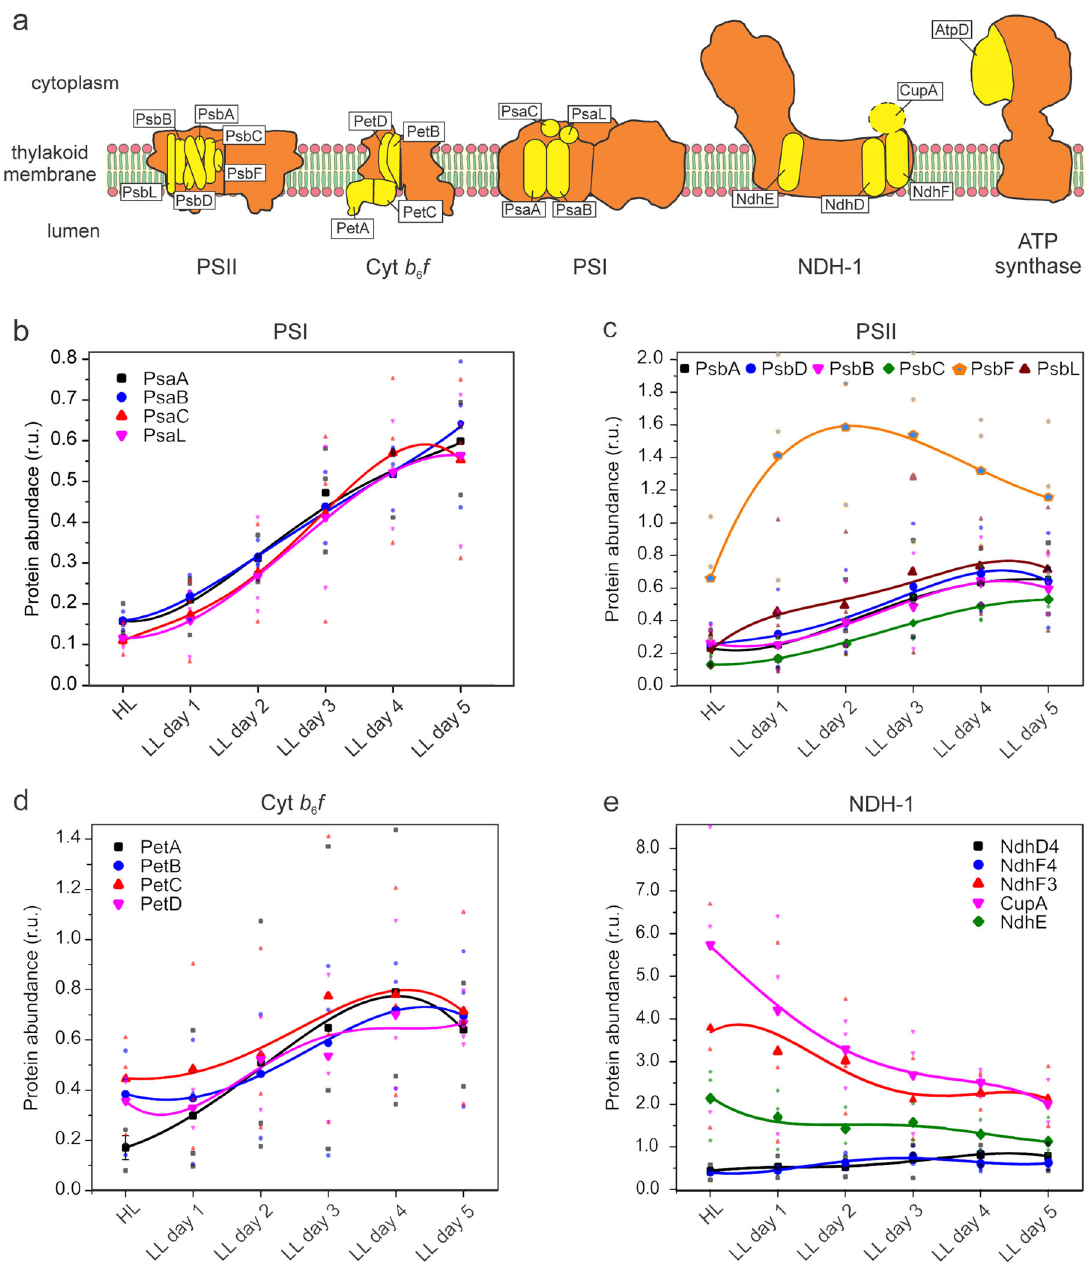
Fig. 3 Expression of protein complexes residing in thylakoid membranes during thylakoid biogenesis. Membrane protein fractions were isolated from Synechococcus cells grown under GL, HL, and HL-grown cells transferred to LL for 5 days. a Scheme of studied subunits from photosystem II (PSII), photosystem I (PSI), cytochrome b 6 f (Cyt b 6 f ), type 1 NAD(P)H dehydrogenase-like complex (NDH-1), and ATPase. Illustration credit: Dr Tuomas Huokko, University of Liverpool; Relative protein quanti fi cation using label-free mass spectrometry data-dependent acquisition of subunits belonging to panel ( b ), PSI; ( c ), PSII; ( d ), Cyt b 6 f and ( e ), NDH-1. r.u., relative unit. Values are represented as means from three biologically independent experiments. All values are normalized to GL-samples. Transparent symbols represent three independent biological replicates. Fitted curves are fourth-degree polynomial functions. The corresponding adjusted R 2 values for fi tting are: PsaA, 0.98151; PsaB, 0.99498; PsaC, 0.99935; PsaL, 0.99967; PsbA, 0.99936; PsbD, 0.97432; PsbB, 0.96176; PsbC, 0.99982; PsbF, 0.99486; PsbL, 0.97164; PetA, 0.99612; PetB, 0.99497; PetC, 0.88053; PetD, 0.91018; NdhD4, 0.94908; NdhF4, 0.88885; NdhF3, 0.52203; CupA, 0.97552; NdhE, 0.61526. The equations of fi tted curves are shown in Supplementary Table